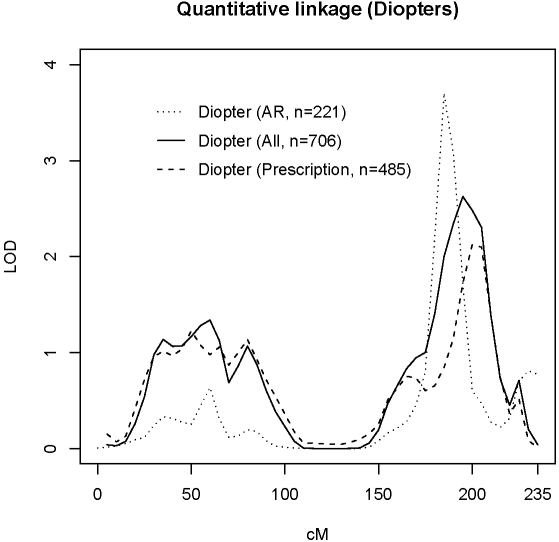
Evidence of replicated linkage to 3q26 region.AR (dotted line) = Autorefractor discovery sample for 221 DZ twin pairs (LOD 3.7) based upon previously published data [7]; Prescription (dashed line) = Replication sample using 485 DZ twin pairs with complete postal prescription data (LOD 2.12); All (solid line) = pooled linkage analysis for 706 DZ twin pairs (LOD 2.63).